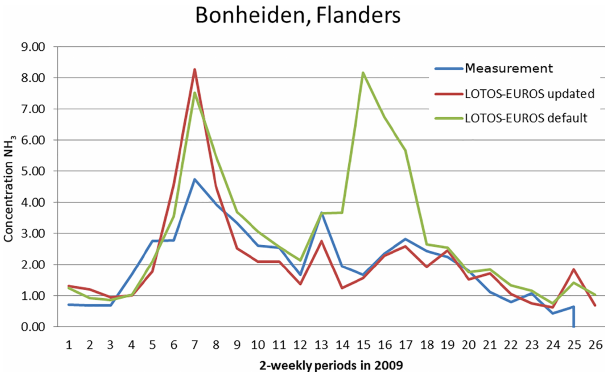
Figure 8. Time series of modelled and measured ammonia concen- trations in Bonheiden (Belgium) in 2009, showing the reduction of the unrealistic second NH 3 peak of the default simulation around period